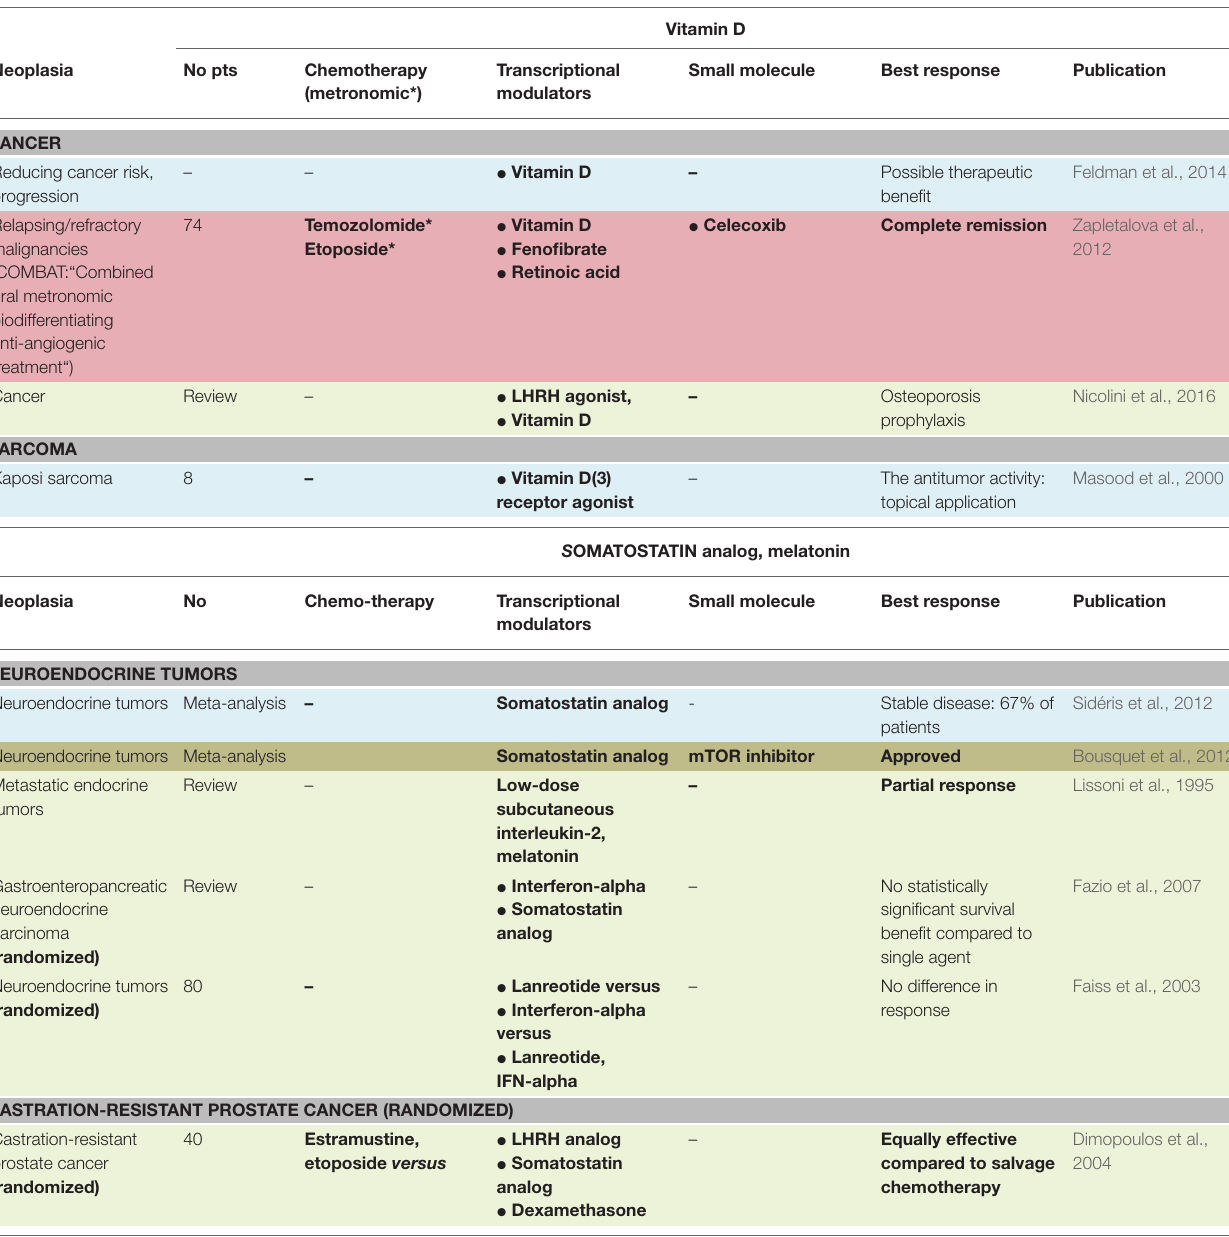
TABLE III | Communicative reprogramming of tumor